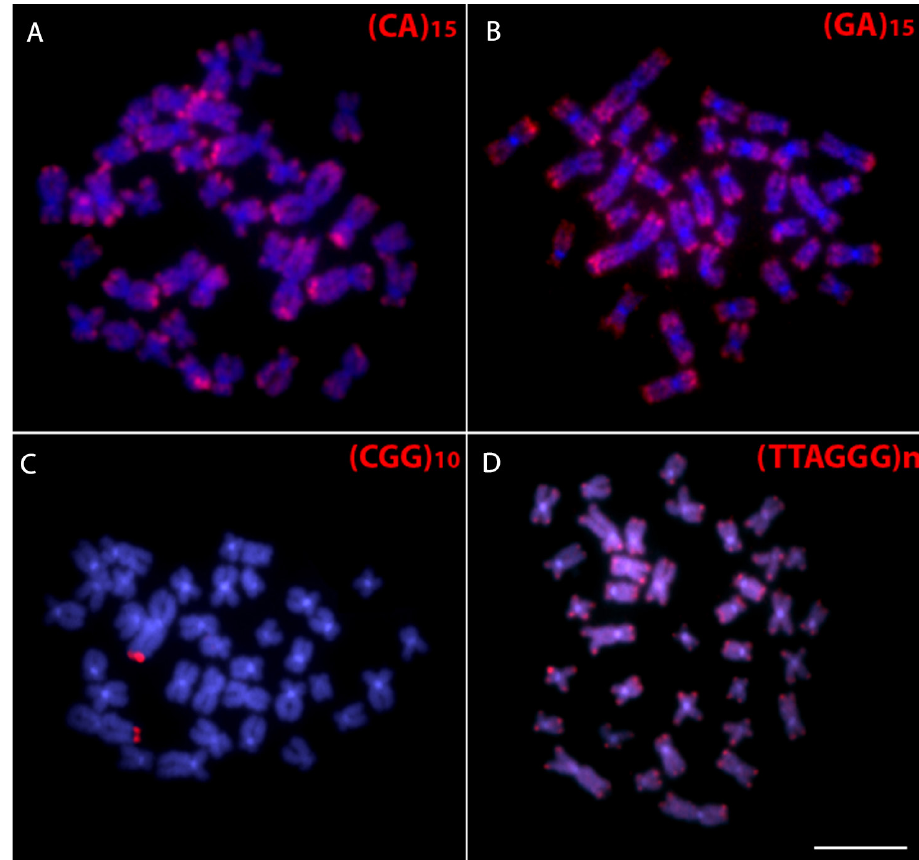
FIGURE 3 | Metaphase chromosomes of Lebiasina minuta hybridized with microsatellite probes ( A , B and C ) and telomeric probes ( D ), using red signals. Scale bar = 5 µm.